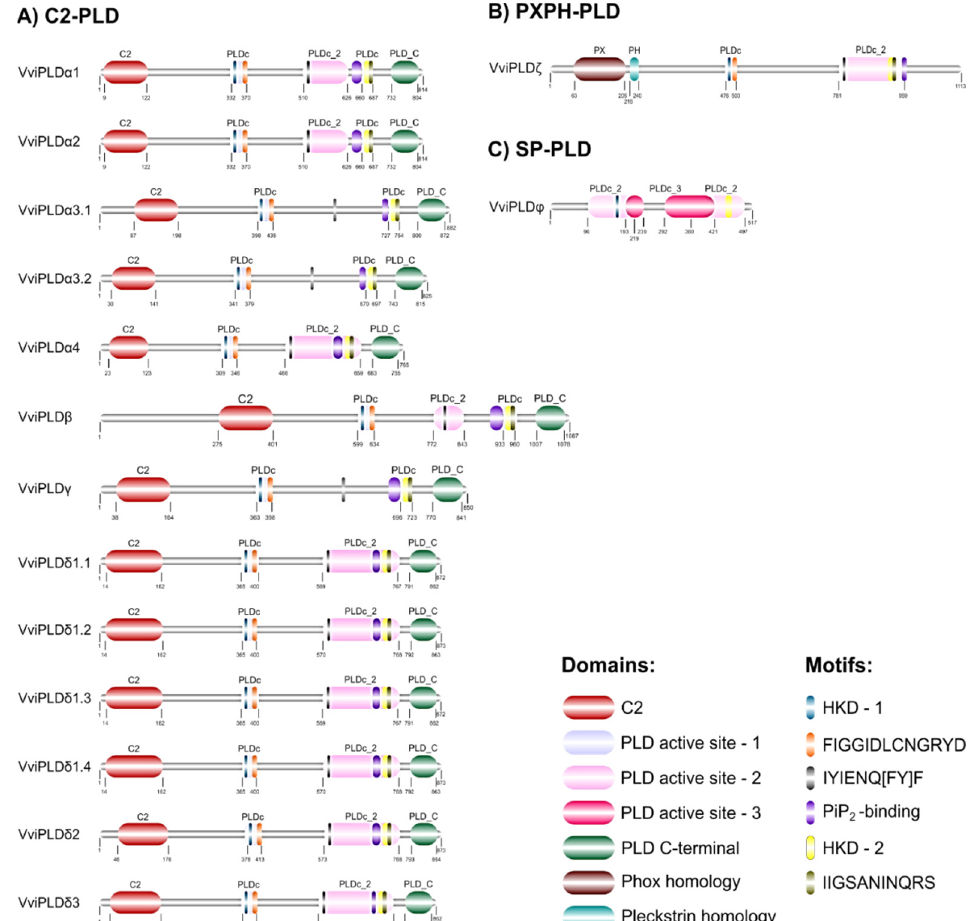
Figure 4. Peptide domain structures and conserved motifs of grapevine PLD members. Schematic diagram representing: ( A ) C2-PLD, ( B ) PXPH-PLD and ( C ) SP-PLD families. Different motifs and domains are indicated by different